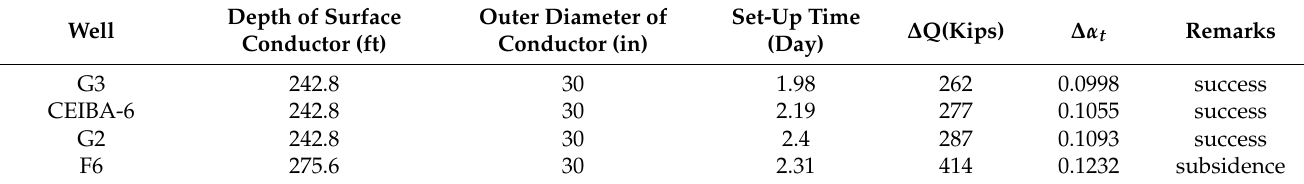
Table 1. Summary of drilling data from Equatorial Guinea